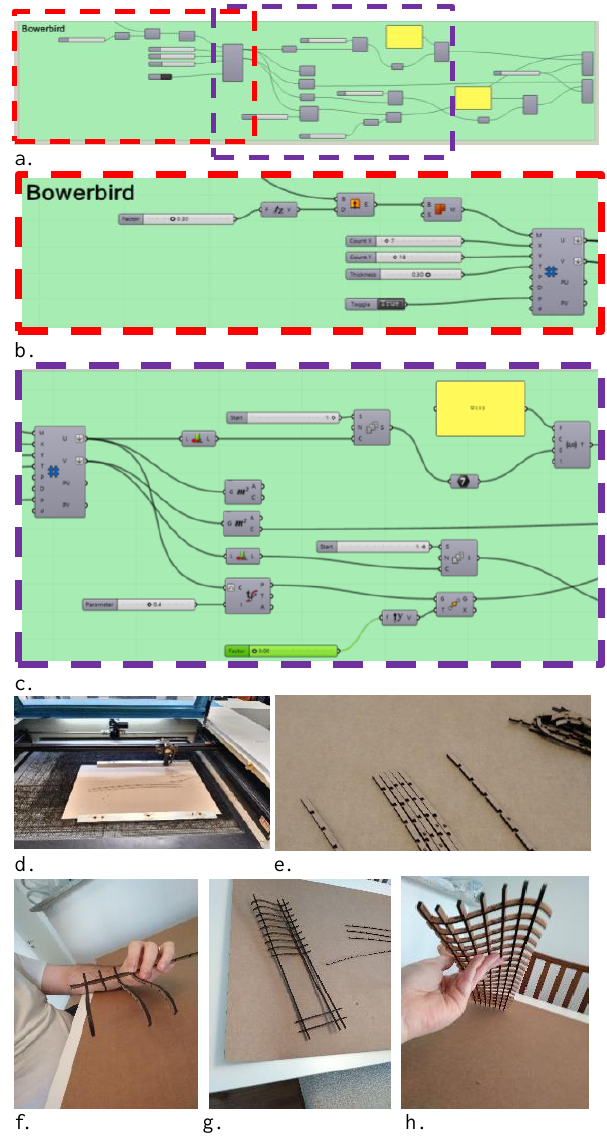
Figure 10: (a) The algorithm developed in Grasshopper© in association with the Bowerbird © plugin and Rhinoceros 3d 6.0© took advantage of the component (b) ‘BB Waffle’, which allowed the (c) CNC cutting of the framework of the roof’s surface of (d) identified ribs and the (e-g) simultaneous positioning of the ribs in the manual assembling